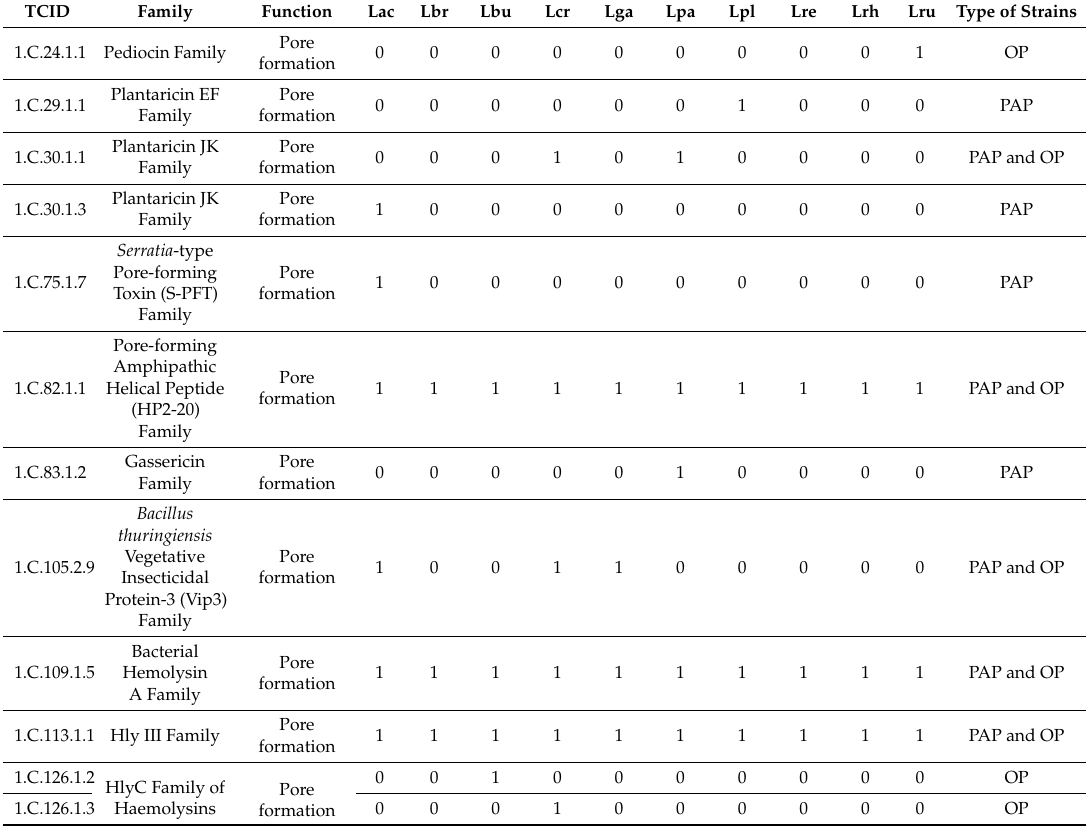
Table 3. Occurrence of pore-forming toxins in the ten Lactobacillus